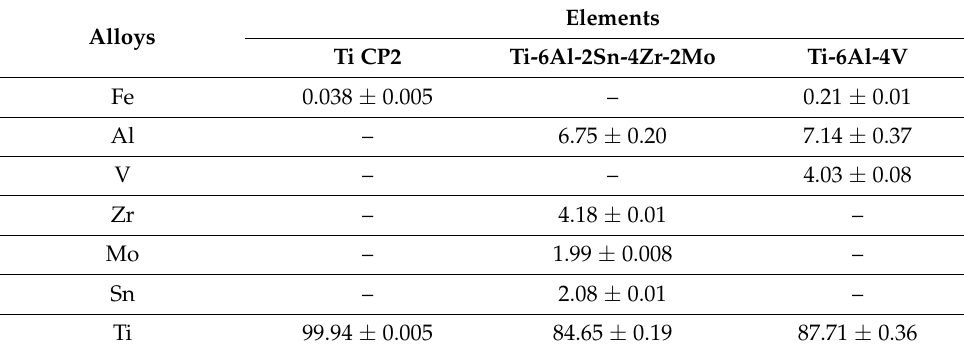
Table 1. Chemical composition of the used titanium alloys (wt